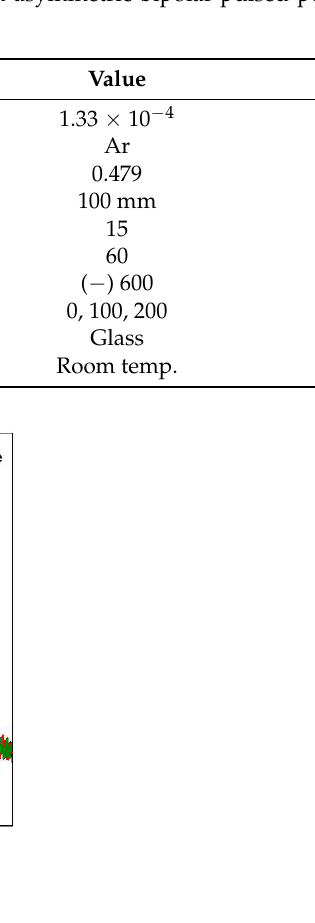
Figure 6. XRD patterns of Ti thin films deposited at extractor voltages of 0, 100, and 200 under a fixed sputter voltage of − 600 V.